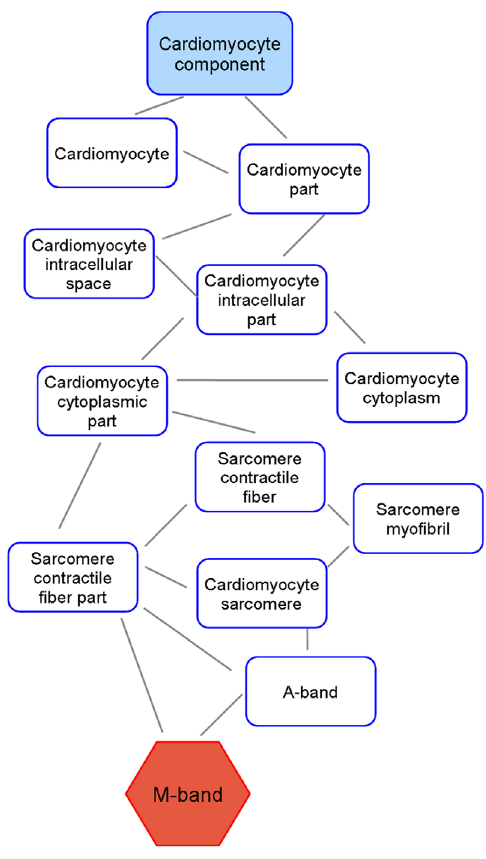
Figure 4. Gene ontology analysis. Acyclic graph showing the M-line cellular component significantly over-represented (in red) in IUGR compared to healthy control hearts. In the GO hierarchy, biological knowledge can be represented as a tree where functional terms near the root of the tree make reference to more general concepts while deeper functional terms near the leaves of the tree make reference to more specific concepts. If a gene is annotated to a given level, then is automatically considered to be annotated at all the upper levels up to the root.